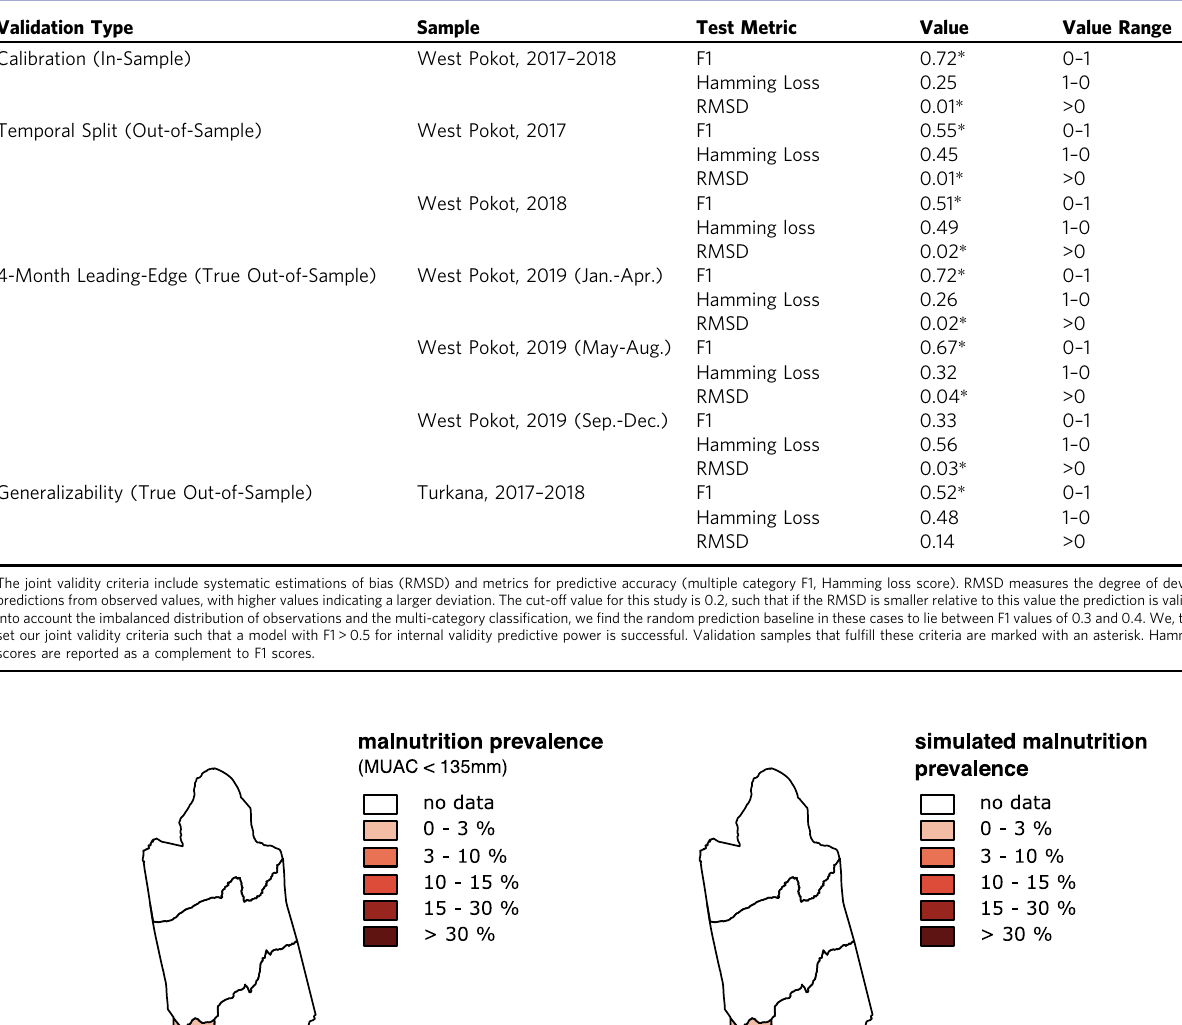
Table 1 provides a summary of validation exercises and corresponding model performance statistics.